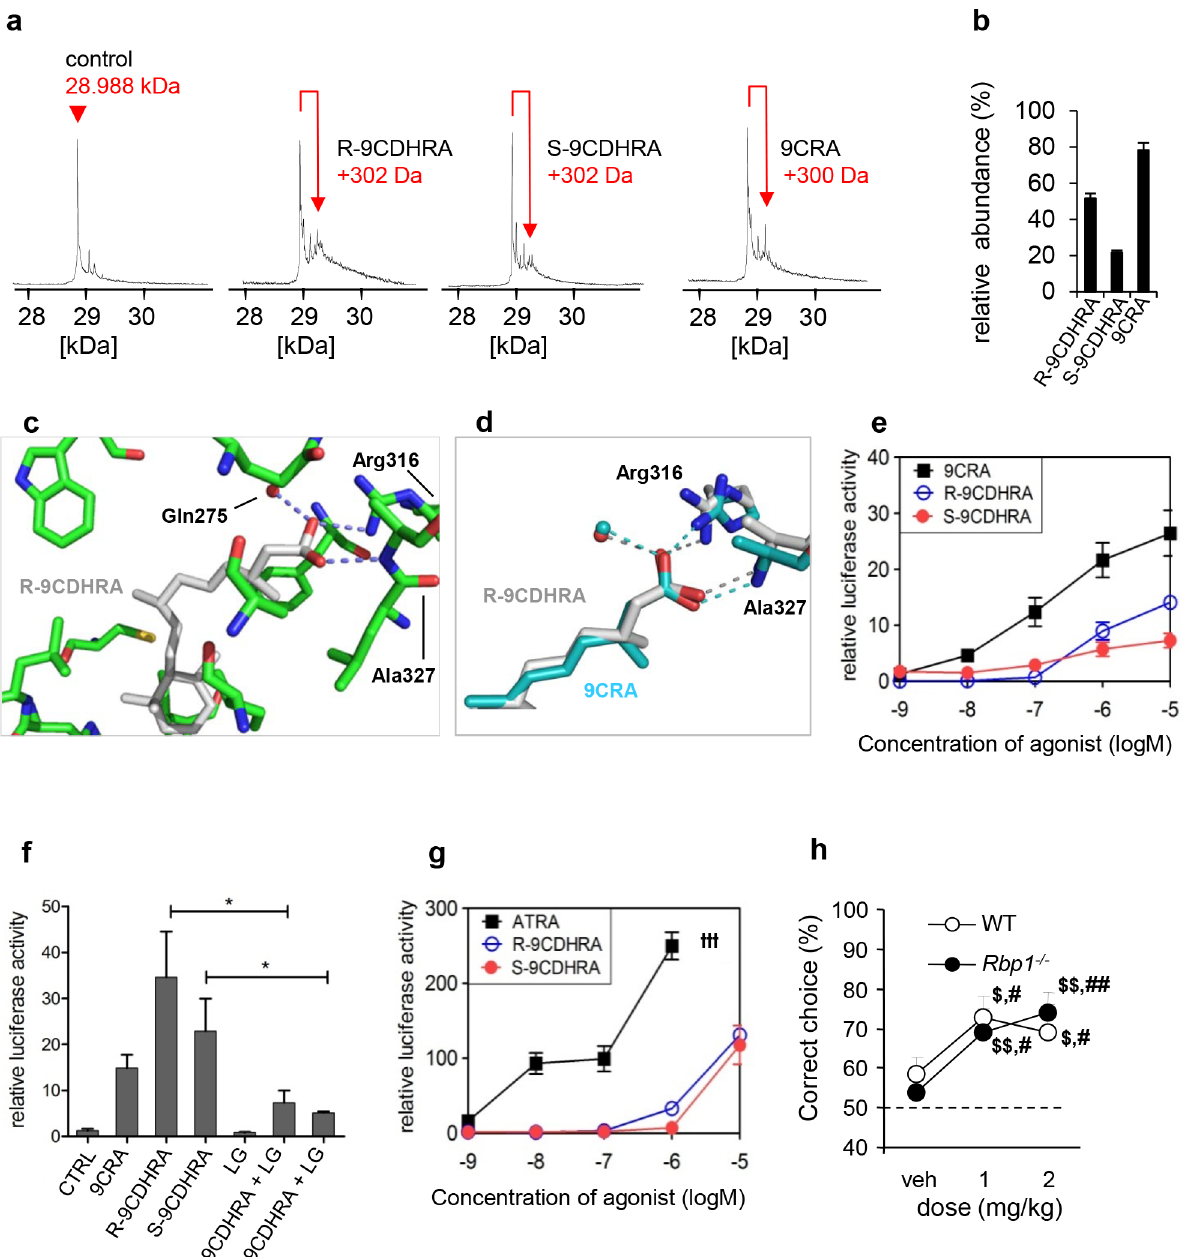
Fig 3. 9CDHRA binds and transactivates RXR in vitro , and displays RXR agonist-like activities in vivo . (a) ESI mass spectra of hRXR α LBD protein after incubation with a 5-fold molar excess of 9CRA, R-9CDHRA and S-9CDHRA. (b) Distribution plot of the percentage of bound hRXR α . (c) Close-up view showing the ligand-binding pocket of RXR α bound to R-9CDHRA (in grey). Residues in close contacts ( < 3.5 Å ) are labelled. Dashed lines indicate hydrogen bonds and the red sphere a water molecule. (d) Superposition of the RXRalpha ligand-binding pocket bound to R-9CDHRA (grey) and 9CRA (cyan, PDB code: 1XDK). Superposition was made on the protein. Hydrogen bonds with R-9CDHRA or 9CRA are shown by grey and cyan dashed lines, respectively. Water molecules are shown by spheres (red for RXR-R-9CDHRA and cyan for RXR-9CRA). (e) Transcriptional activation of RXR α by R-9CDHRA and S- 9CDHRA in comparison to 9CRA (10 – 5 – 10 -9 M) in RXR-reporter COS1 cells. (f) 9CRA (10 -7 M) and both 9CDHRA enantiomers (10 -5 M) induced RXR α - mediated signaling. RXR-antagonist LG101208 (LG; 10 -6 M) diminished activity of both 9CDHRA enantiomers (10 -5 M). (g) Transcriptional activation of RAR-RXR heterodimers by R- and S-9CDHRA in comparison to ATRA in RAR α -RXR α -reporter COS1 cells. (h) Increasing doses of R-9CDHRA reversed working memory deficits in Rbp1 -/- mice and showed pro-mnemonic activity in WT mice (n = 8/group) in DNMTP task when tested at minimal ITI, at which mice performed at chance level (50%) and which was 6min for the Rbp1-/- or 12min for WT mice. ttt: ATRA at concentration 10 – 5 M was cytotoxic. * , p < 0.05. #, p < 0.05; ##, p < 0.01 as compared to vehicle treatment in the same group; $, p < 0.05; $$, p < 0.01; one group student t-test for comparison with performance at chance level of 50%. All the error bars represent